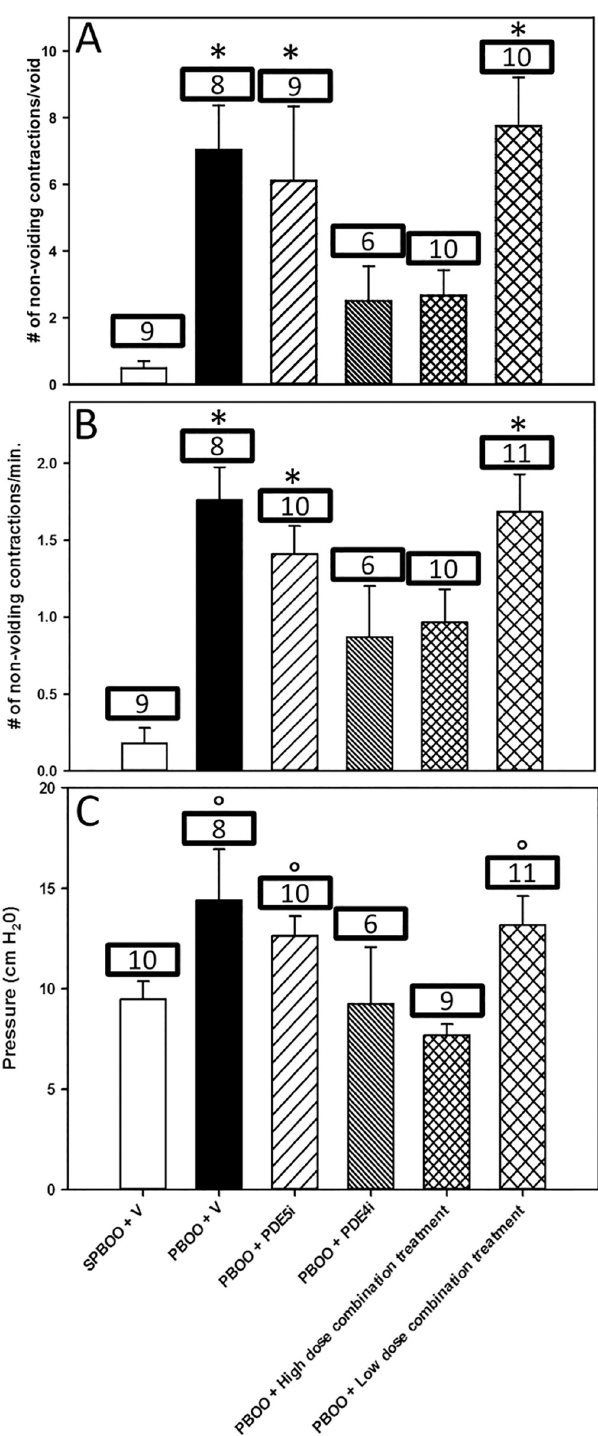
Fig 4. Primary results of anesthetized cystometry including: Number of non-voiding contraction per void (A), Non-voiding contraction per minute (B), and threshold voiding pressure (C) in rats receiving: Sham partial bladder outlet obstruction (PBOO) and vehicle (SPBOO +V), PBOO and vehicle (PBOO + V), PBOO and PDE5i alone (PBOO + PDE5i), PBOO and PDE4i alone (PBOO + PDE4i), PBOO and high dose combination treatment (PBOO + high dose combination treatment) and PBOO and low dose combination treatment (PBOO + low dose combination treatment). Data is presented as mean ± standard error in each group. The number of animals per